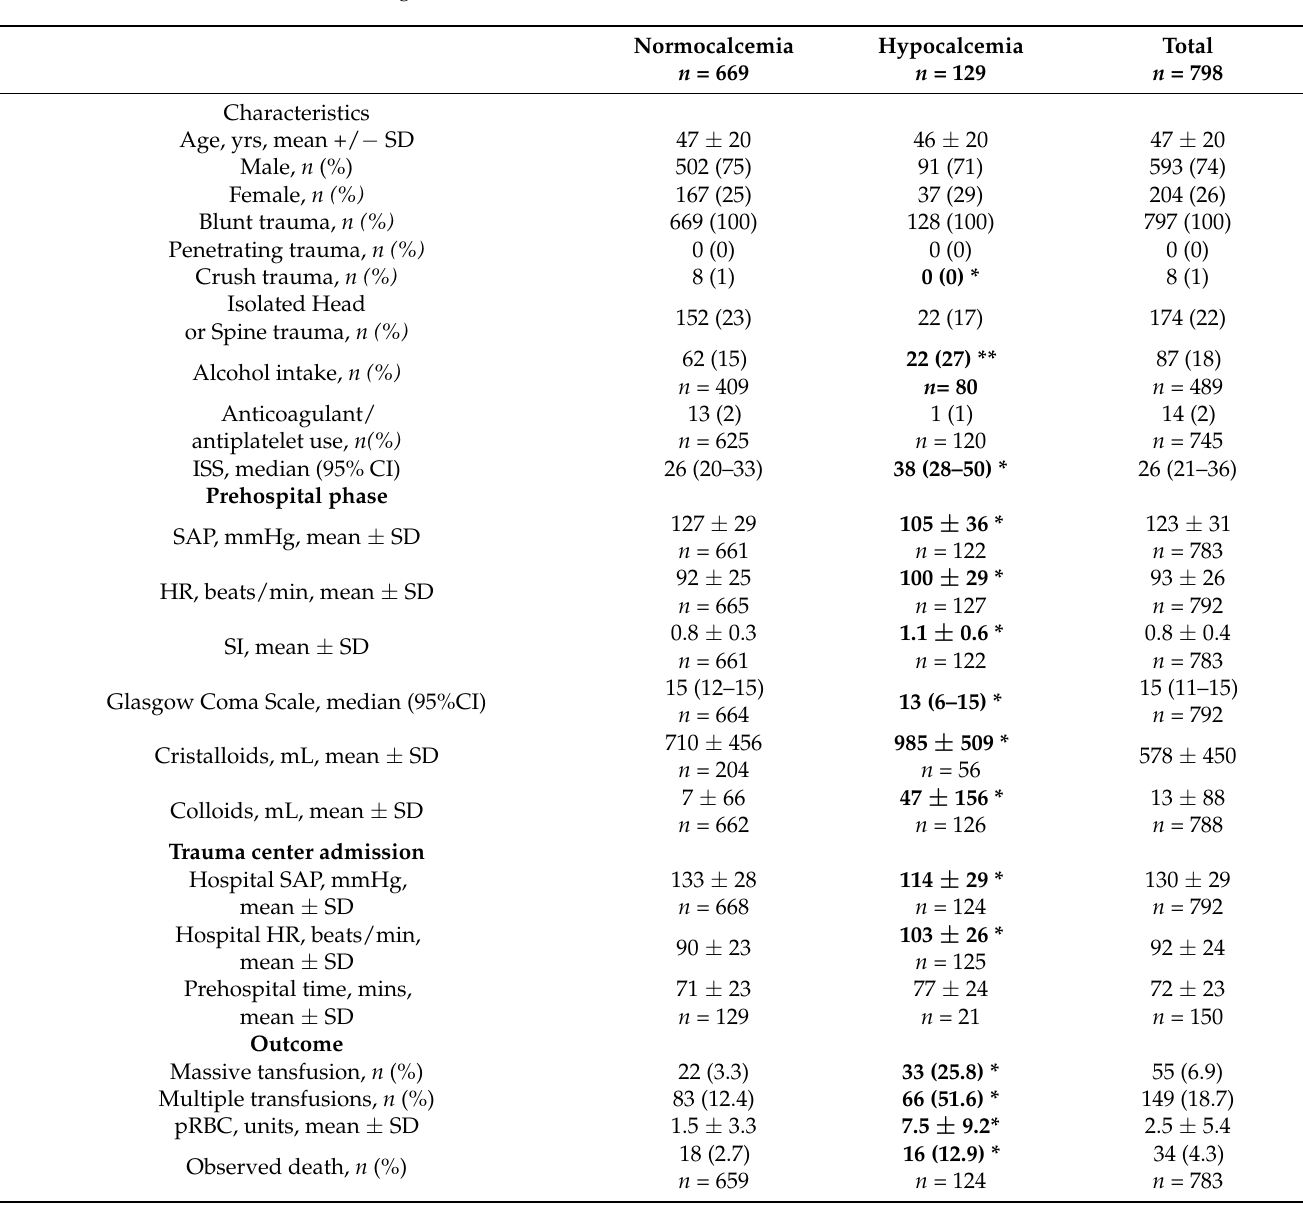
Table 1. Clinical characteristics of the included patients. ( n : number of patients, * p < 0.01, ** p < 0.001, bold: